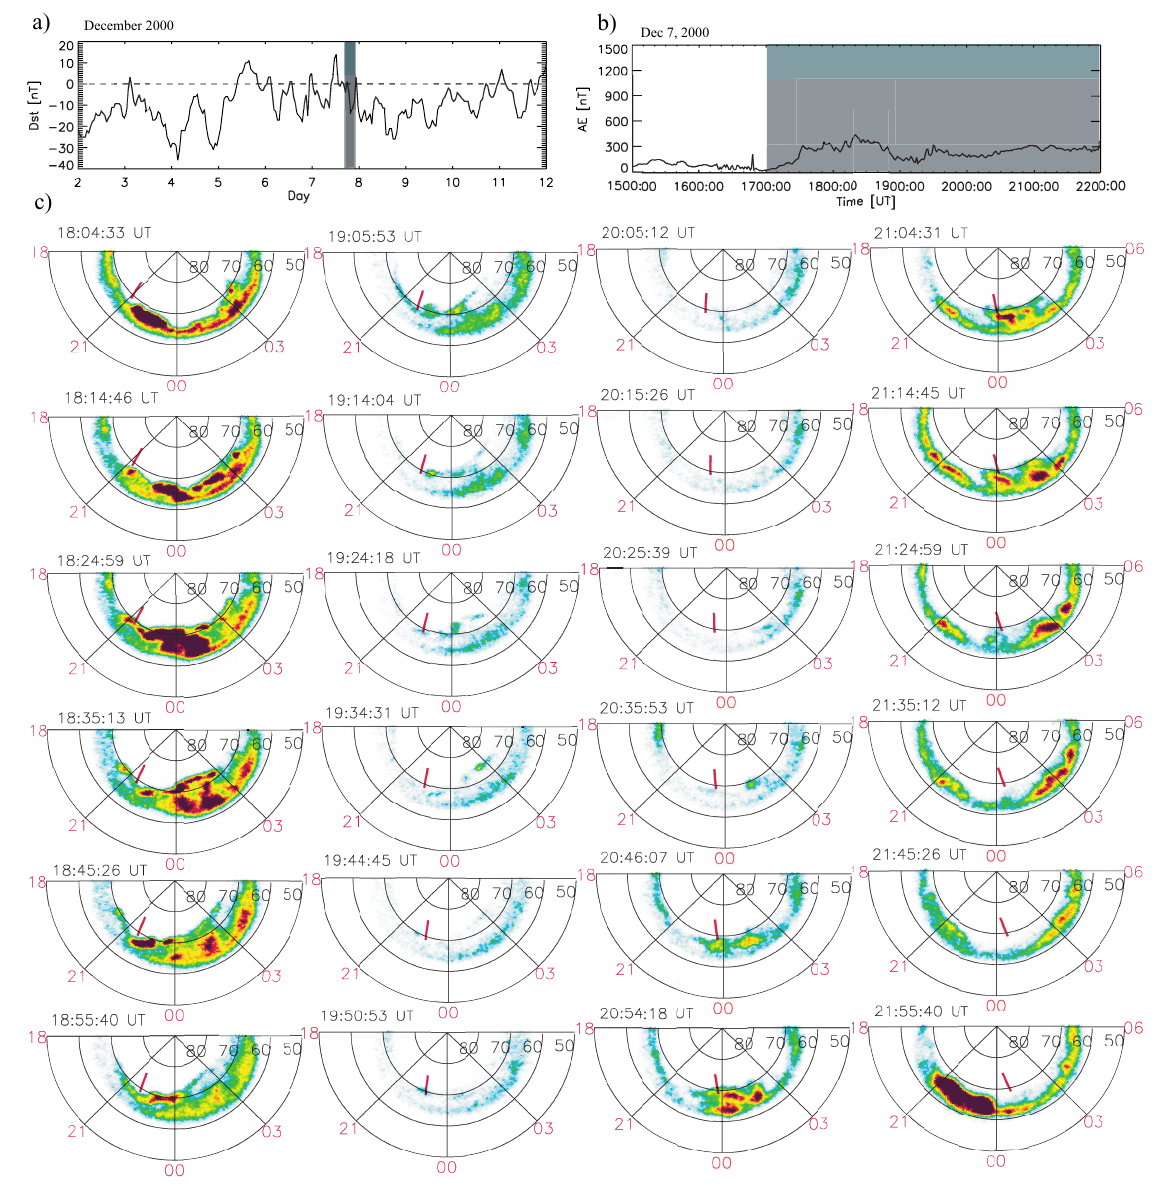
Fig. 8. ( a ) D st and ( b ) AE indices during the observations on 7 December 2000. ( c ) IMAGE/ FUV WIC images from 18:00–22:00 UT. The EISCAT Svalbard radar beam is marked with a red